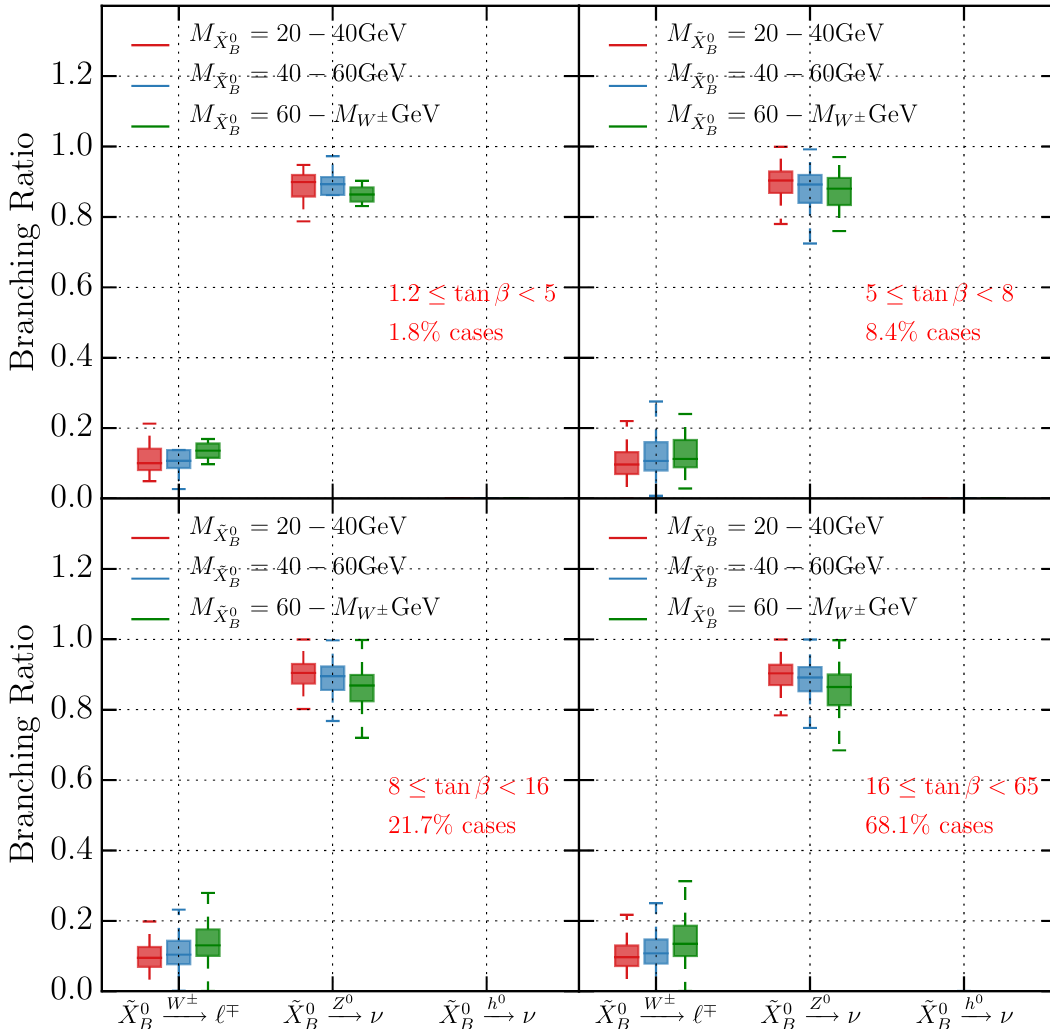
Figure 14. Branching ratios for the three possible decay channels of a Bino neutralino LSP divided over three mass bins and four tan (cid:12) regions. We studied the viable points for Bino LSPs with masses smaller than the mass of the W (cid:6) bosons but larger than 20 GeV. The colored horizontal lines inside the boxes indicate the median values of the branching fraction in each bin, the boxes indicate the interquartile range, while the dashed error bars show the range between the maximum and the minimum values of the branching fractions. The case percentage indicate what percentage of the physical mass spectra have tan (cid:12) values within the range indicated. We assumed a normal neutrino hierarchy, with (cid:18) 23 = 0 : 597. Note that the branching ratios via an o(cid:11)-shell h 0 , while non-vanishing, are of order 10 (cid:0) 3 and smaller and, hence, too small to appear in the